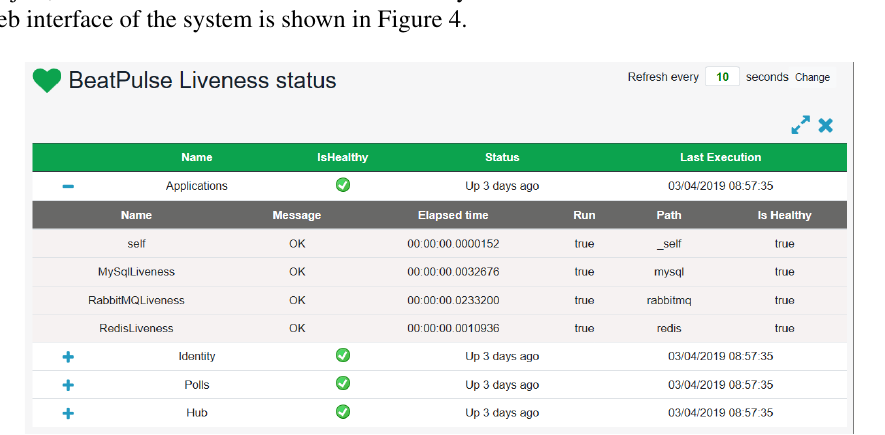
Figure 4. The web BeatPulse Liveness interface of the Winventory